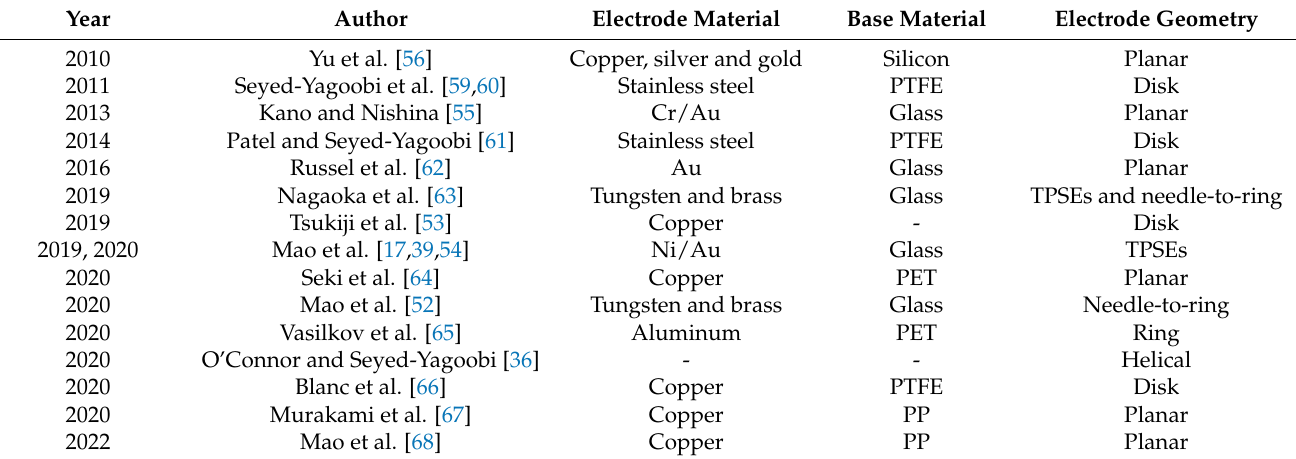
Table 2. Summarized material and geometry of functional fluidic EHD pumps in recent years.